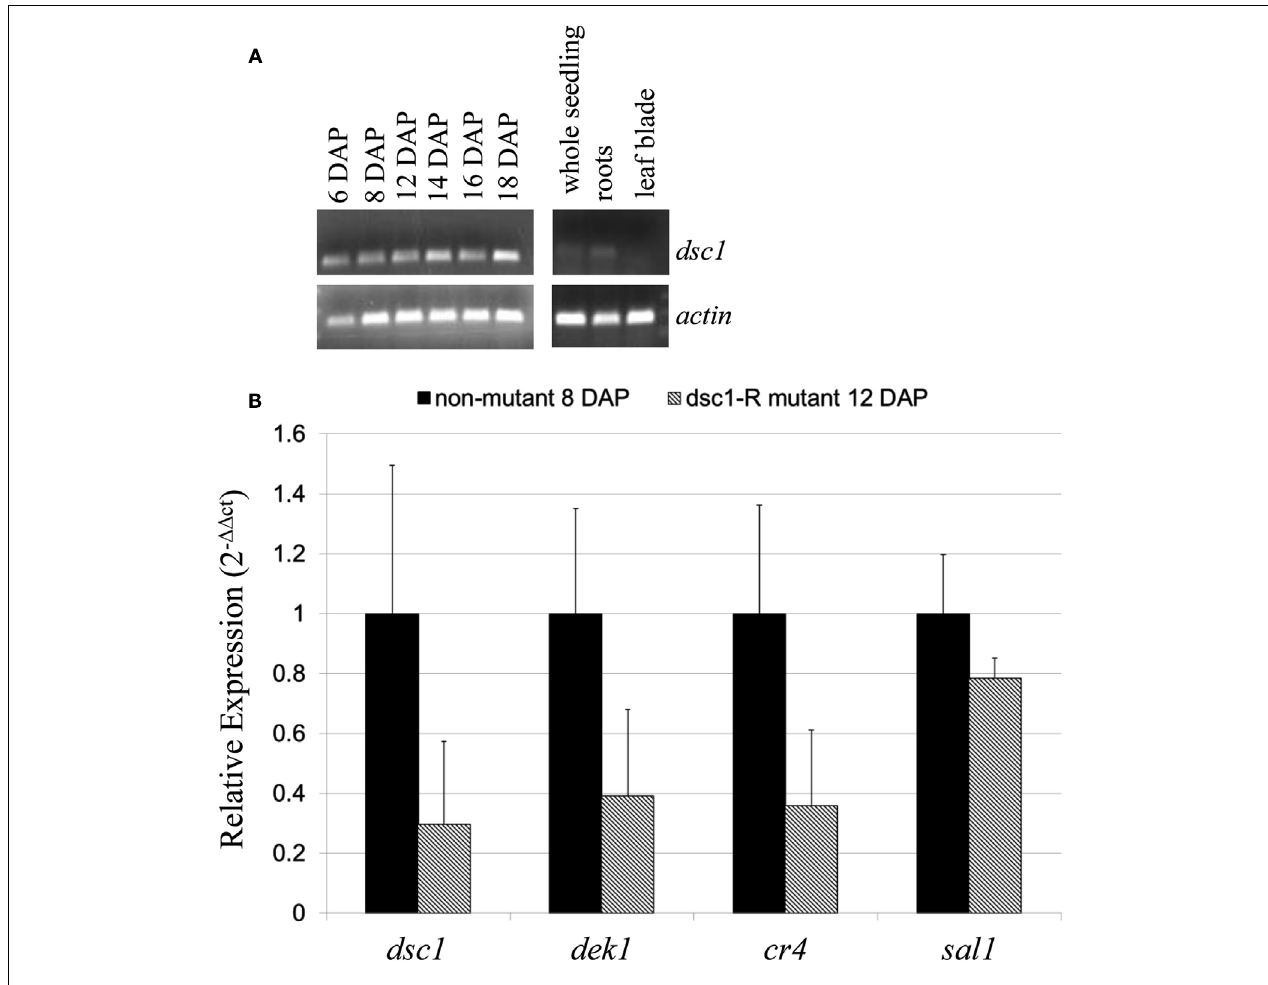
FIGURE 6 |Transcript accumulation of dscl . (A) RT-PCR of dscl transcript accumulation in developing maize kernels (6–18 DAP), 14-day-old seedlings, 14-day-old roots, and leaf blade tips. (B) qRT-PCR analysis of dscl , dekl , cr4 , and sall in 8 DAP non-mutant and dscl-R mutant